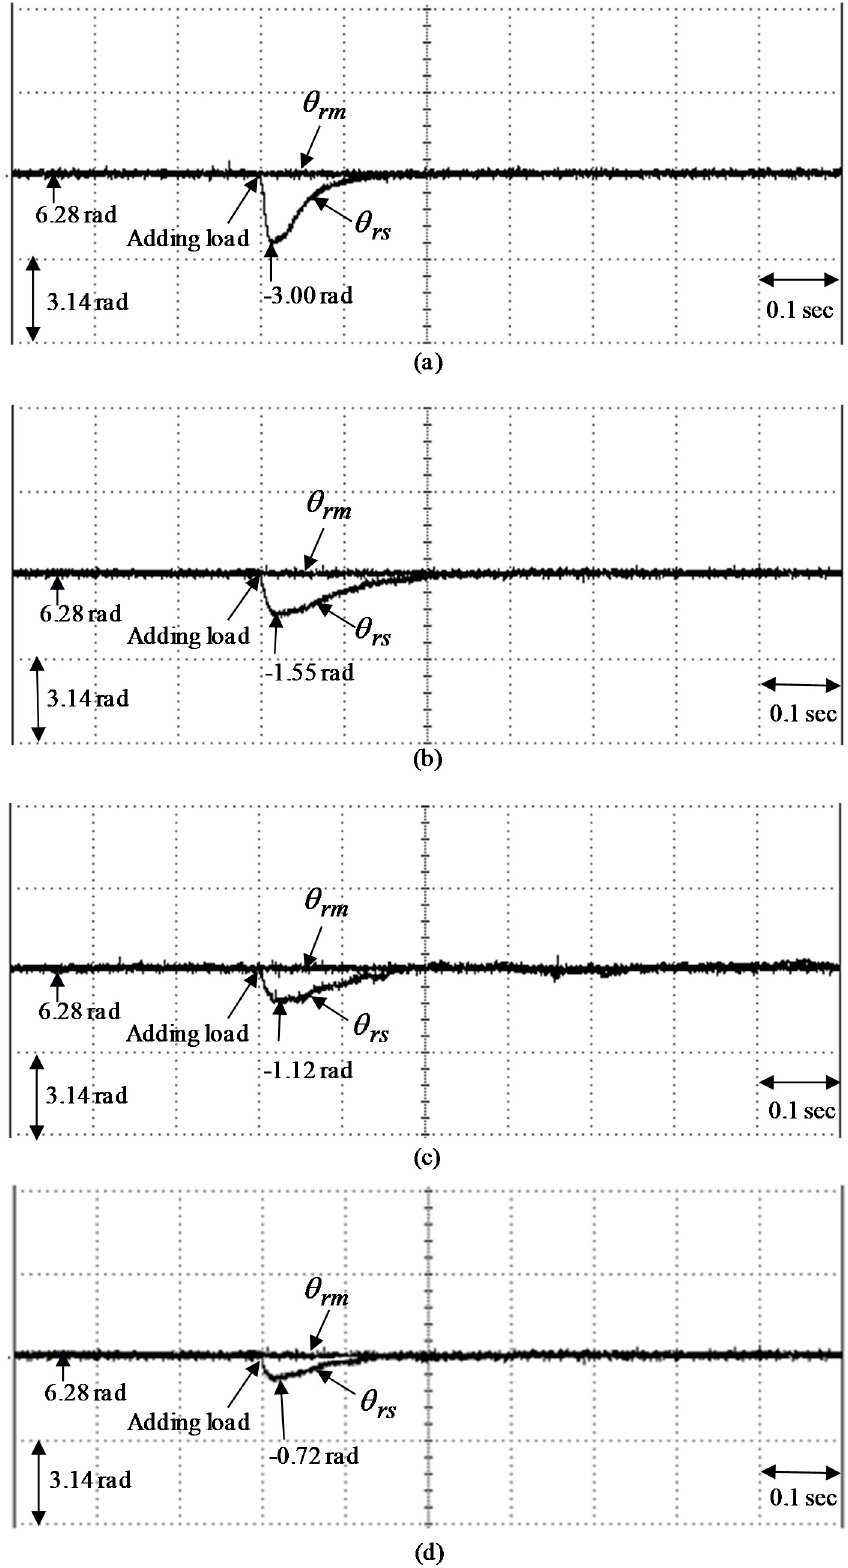
Figure 16. Experimental results of the rotor position response in Case R5 ( a ) by utilizing control system W1, ( b ) W2, ( c ) W3, and ( d ) W4.